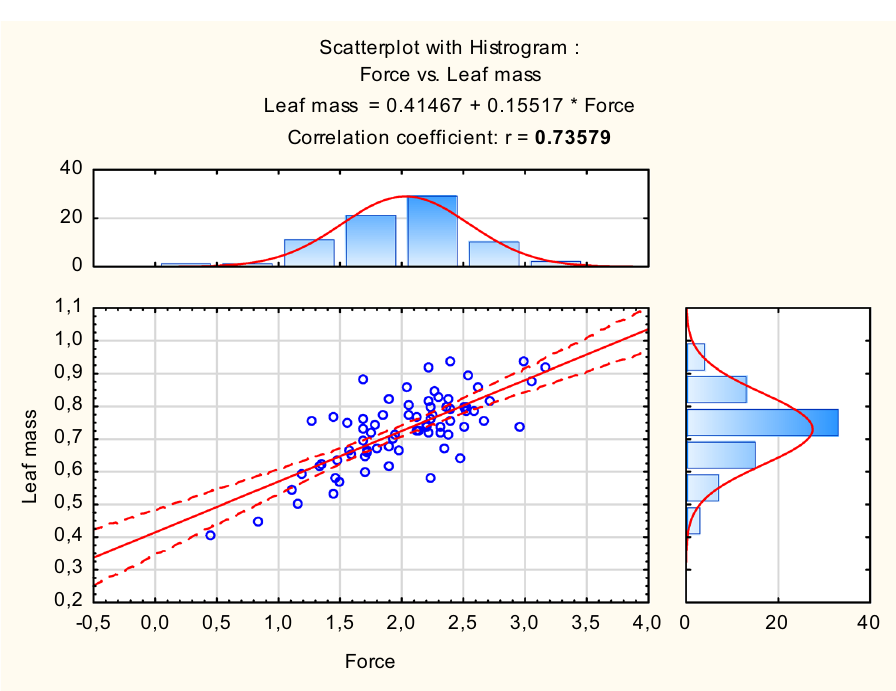
Scatterplot with Histrogram : Force vs. Leaf mass